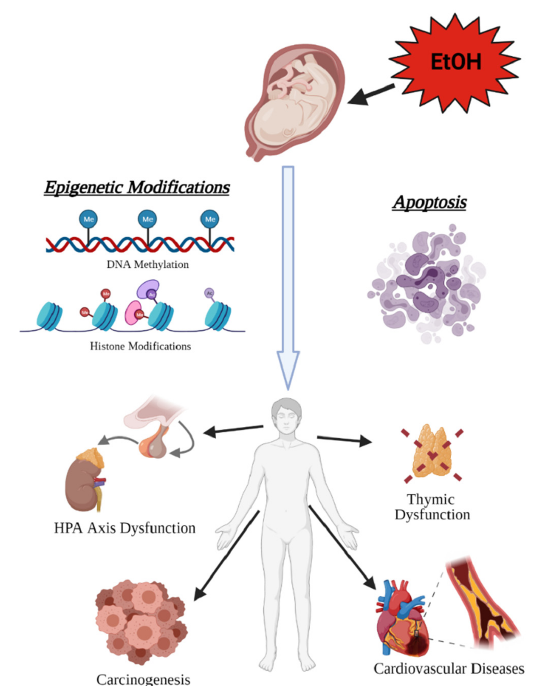
Figure 3. Prenatal alcohol exposure (PAE)has lifelong consequences on health. The toxic and tera- togenic effects of alcohol exposure in utero manifest later in life as increased risk of hypothalamic– pituitary–adrenal (HPA) axis dysfunction, carcinogenesis, cardiovascular disease, and immune system dysfunction resulting from abnormal organogenesis (created with BioRender.com; accessed on 7 July